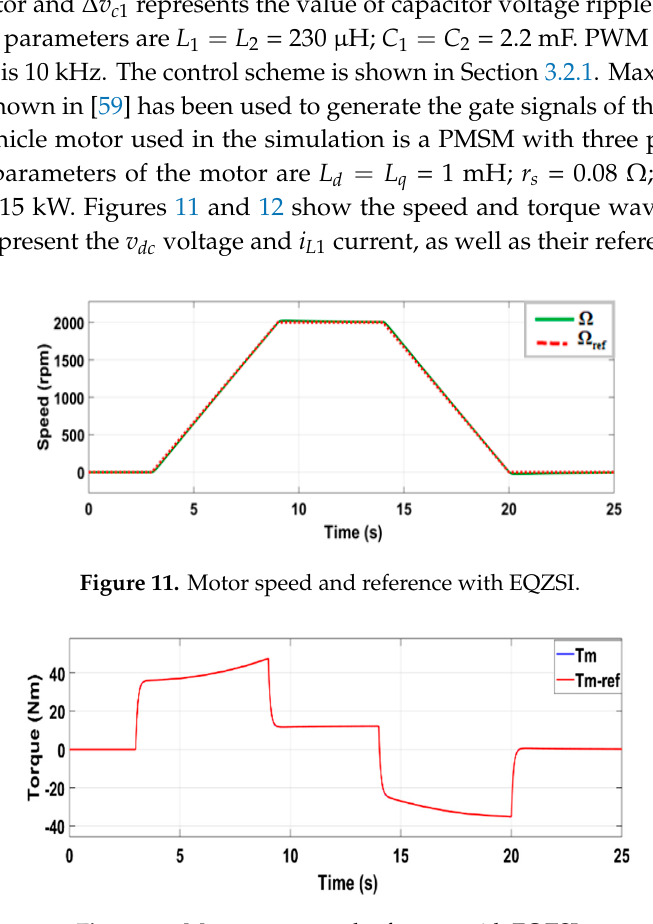
Figure 13. The dc v voltage and reference with EQZSI